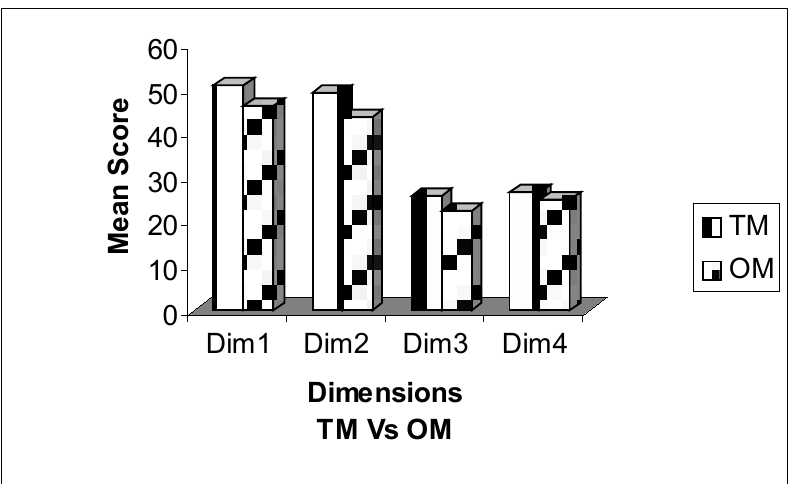
Figure 4 . Dimension-wise comparison of mean values for academic motivation of TES and OES male students.